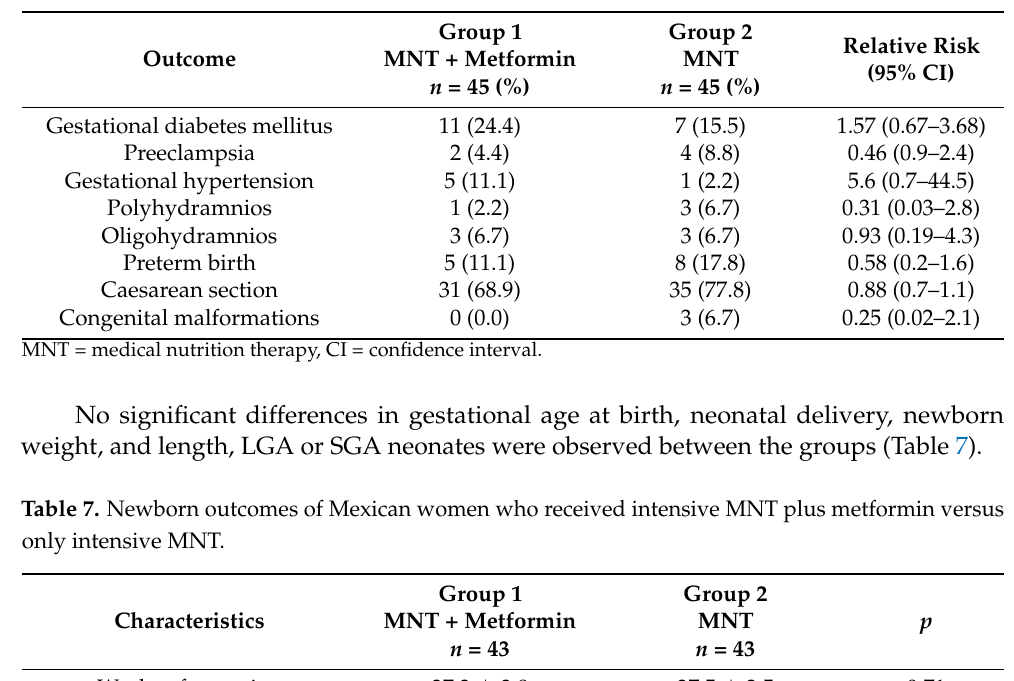
Table 6. Relative risk of adverse perinatal outcomes in Mexican women who received intensive MNT plus metformin versus only intensive MNT to prevent gestational diabetes mellitus.